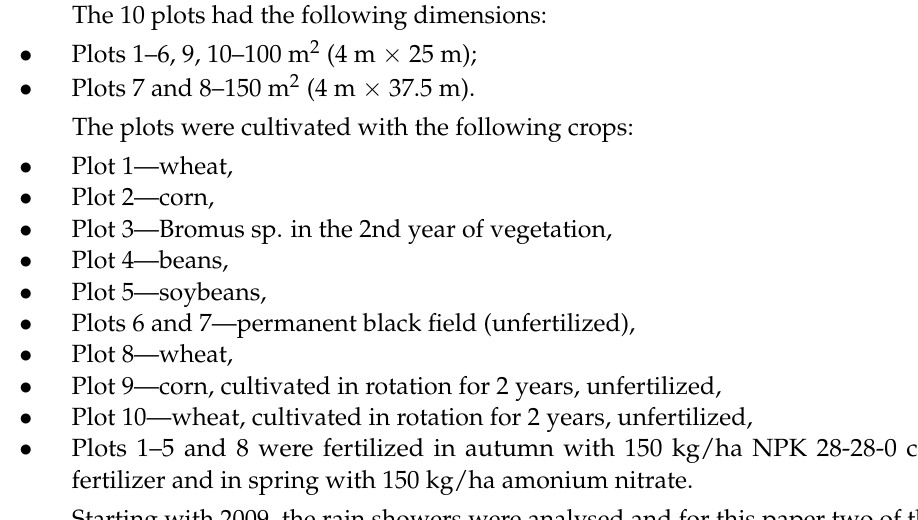
Figure 3. Standard plots for drain control-detail. Source: [7].